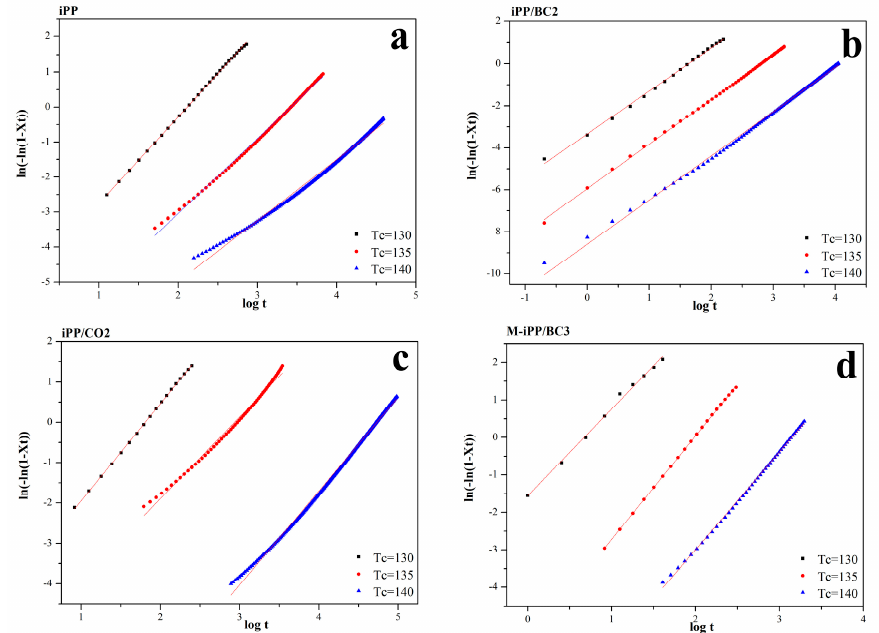
Figure 4. Isothermal crystallization kinetics curves of the iPP/BC composites. ( a ) iPP ( b ) iPP/BC2 ( c ) iPP/CO2 ( d ) M-iPP/BC3. Table 2. The isothermal crystallization kinetic parameters of the iPP/BC composites.